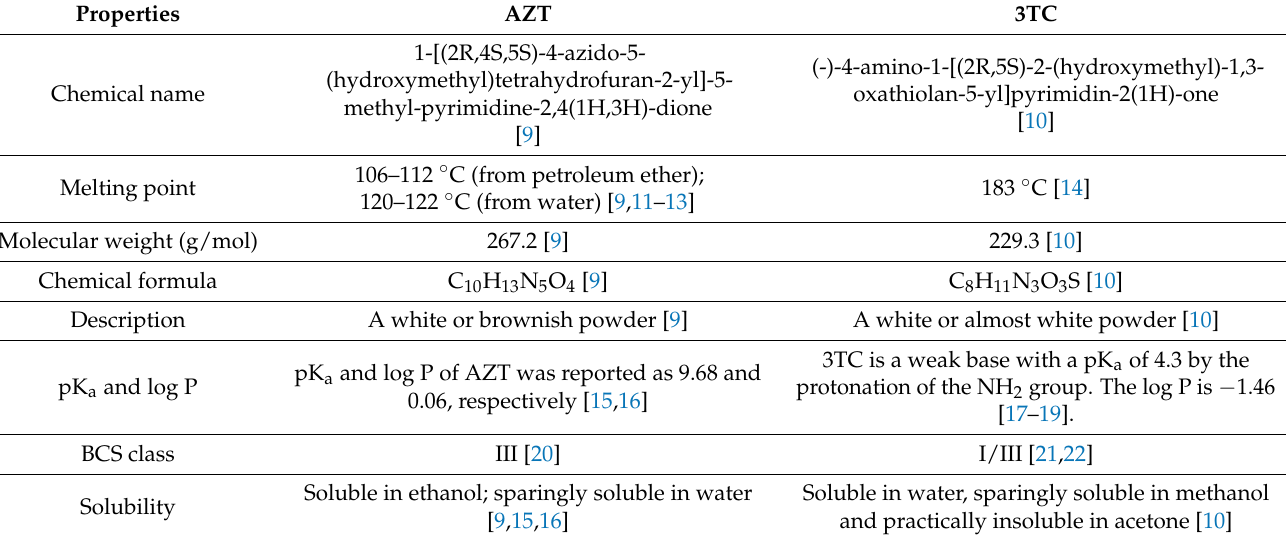
Table 1. Summary of the physicochemical properties of zidovudine (AZT) and lamivudine